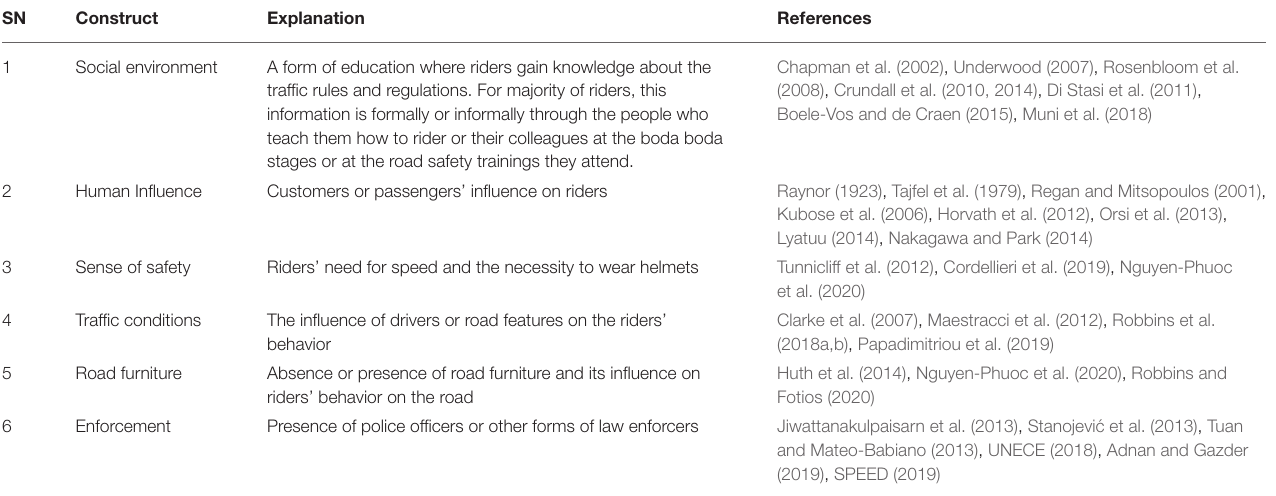
TABLE 1 | Definition of latent constructs examined in this study.